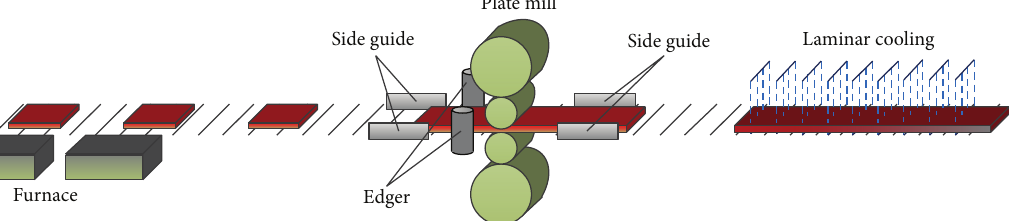
Figure 1: Plate mill scheme.